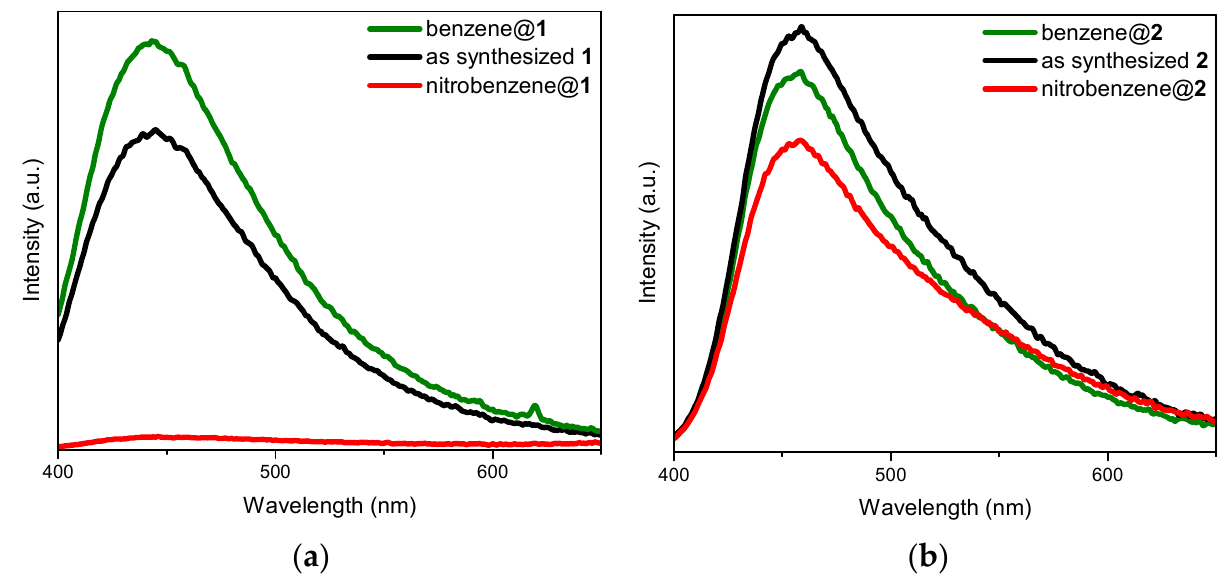
Figure 8. ( a ) Emission spectra of as synthesized 1 , soaked in benzene and nitrobenzene, λ ex = 380 nm; ( b ) Emission spectra of as synthesized 2 , soaked in benzene and nitrobenzene, λ ex = 380 nm.